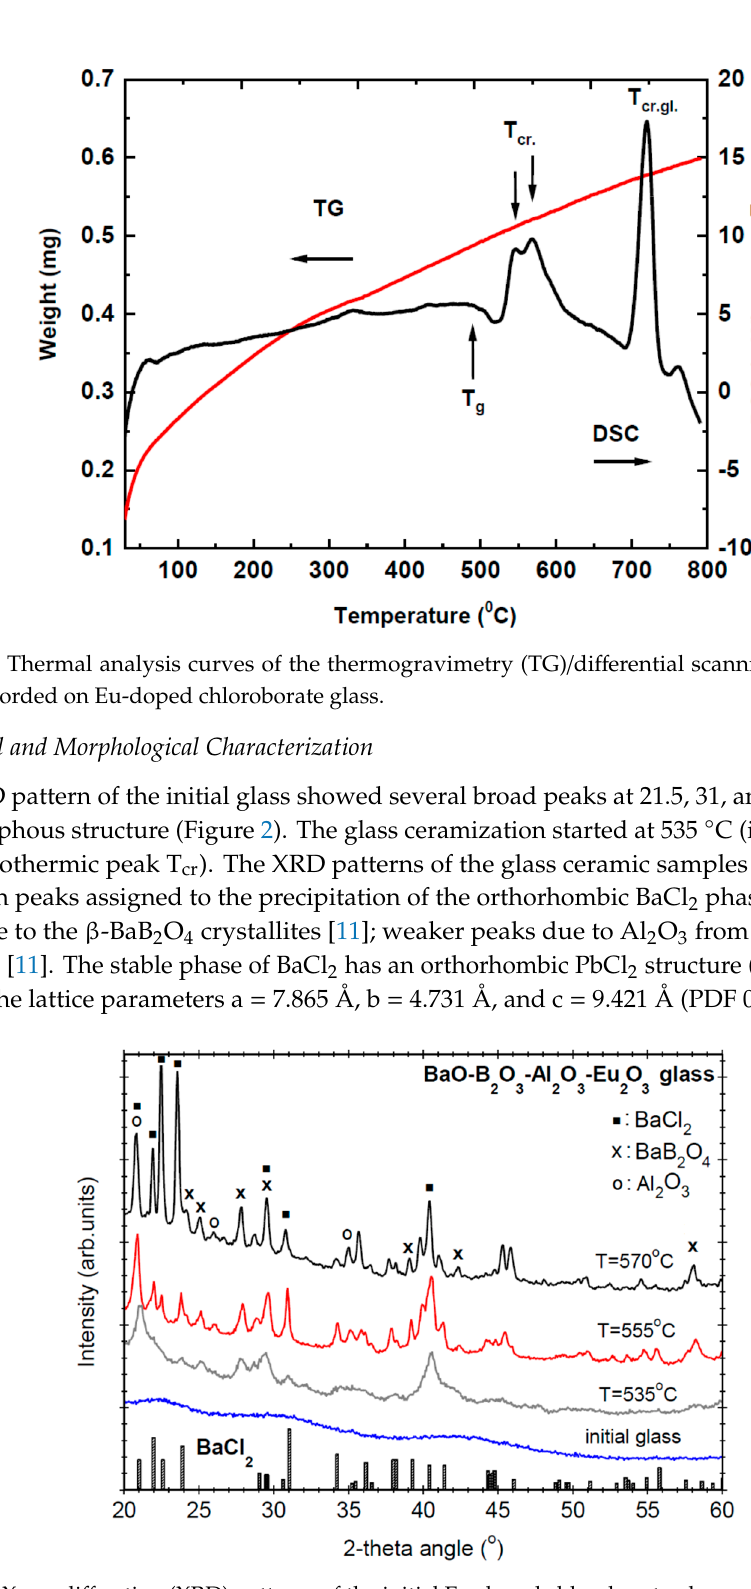
Figure 2. X-ray diffraction (XRD) patterns of the initial Eu-doped chloroborate glass and glass-ceramic after subsequent annealing at indicated temperatures by comparison to orthorhombic BaCl 2 (PDF 00-024-094; the peak assignments of β -BaB 2 O 4 and Al 2 O 3 are indicated).